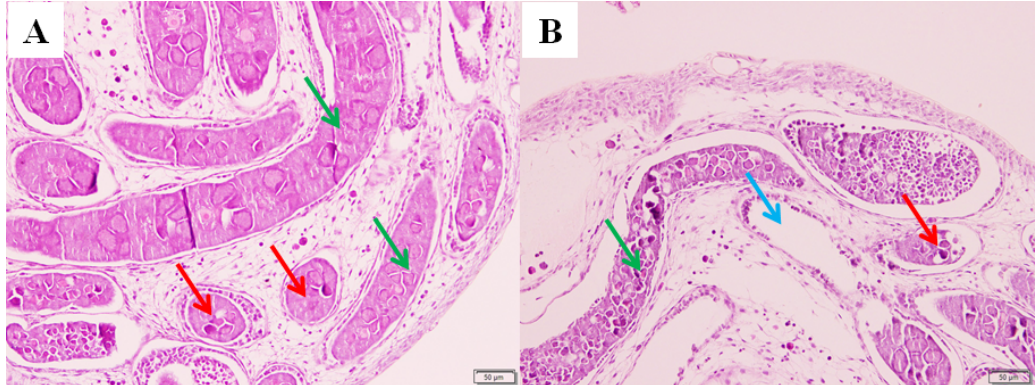
Figure 2. Histological images of ovary tissue in fifth-instar B. mori larvae at 96 h after pyriproxyfen